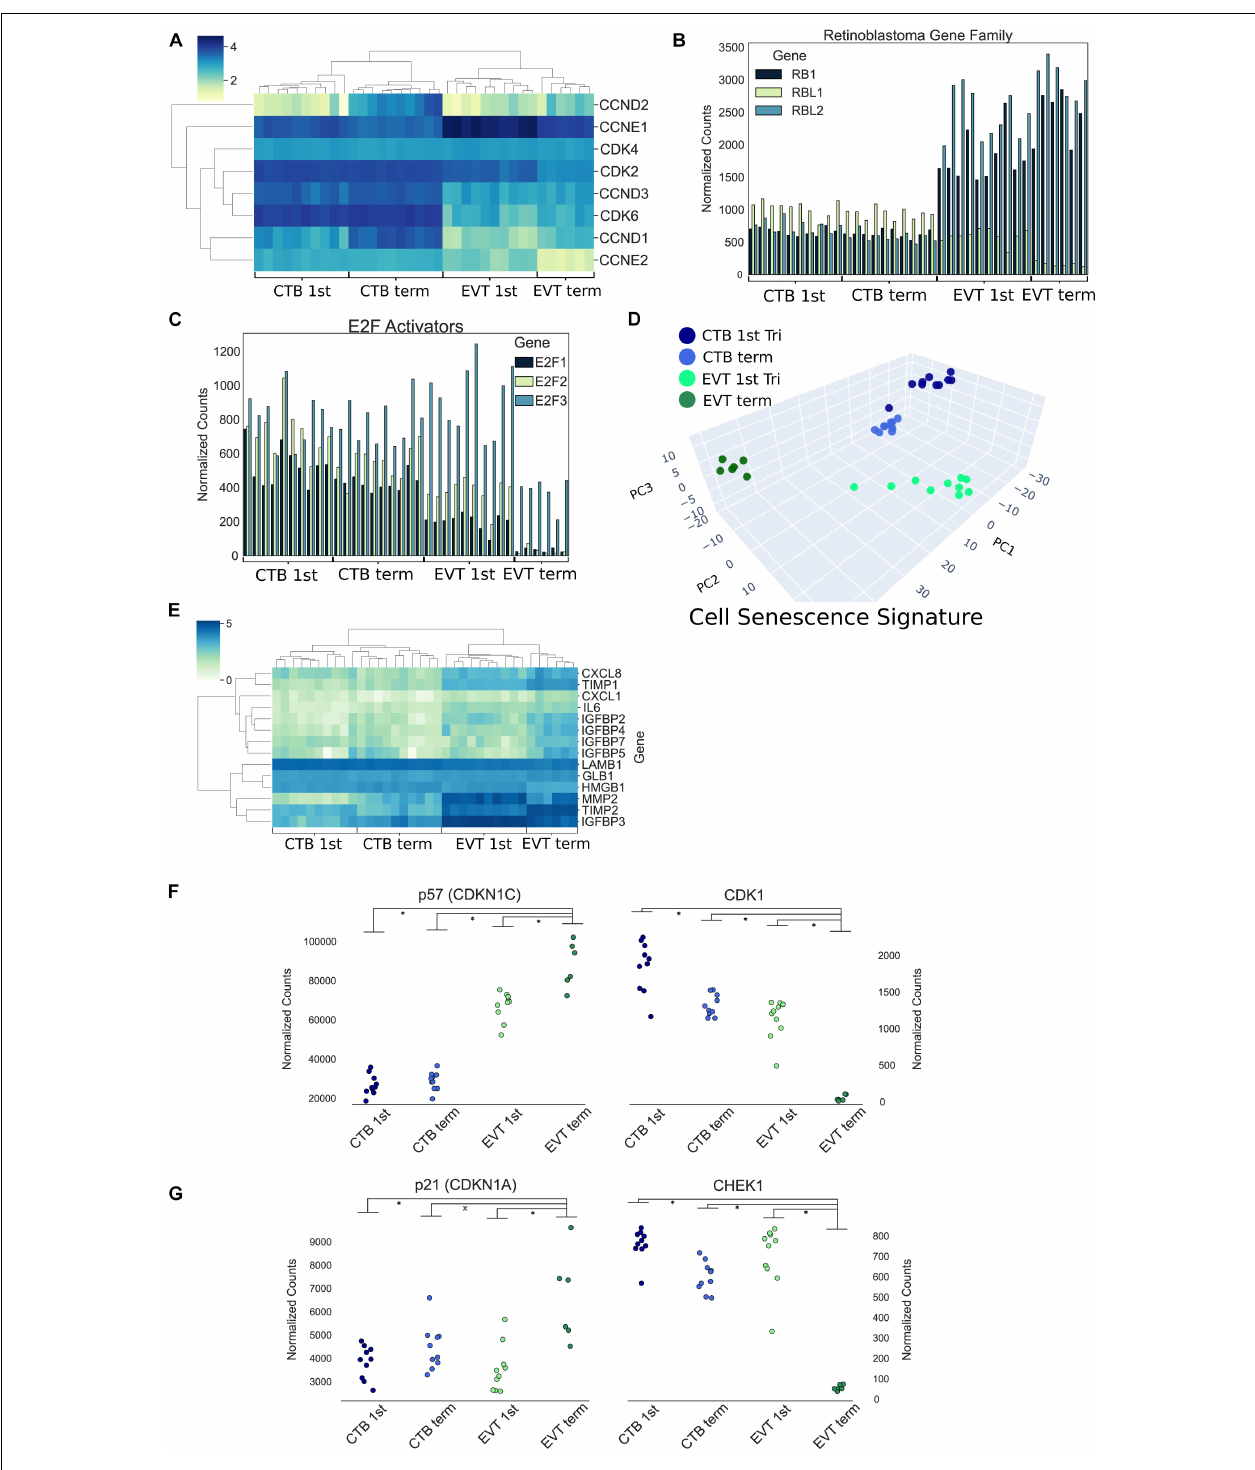
FIGURE 6 | Cell cycle and endoreduplication gene expression. (A) Heatmap of G1 phase cyclins and cyclin-dependent kinases using log transformed normalized gene counts. (B) Bar graph showing retinoblastoma family genes ( RB1 , RBL1 , and RBL2 ) normalized gene expression. (C) Bar graph displaying E2F activators (E2F1, E2F2, and E2F3) normalized gene expression. (D) Three-dimensional principal component analysis using genes ( n = 1,225) associated with human cellular senescence signature. (E) Heatmap of previously identified (Basisty et al., 2020) senescence-associated secretory phenotype (SASP)-associated genes using log transformed normalized gene counts. (F) Normalized expression of p57 (CDKN1C) and CDK1 ( p -value: ∗ < 0.01 by t -test). (G) Normalized expression of p21 (CDKN1A) and CHEK1 ( p -value: ∗ < 0.05 by t -test).